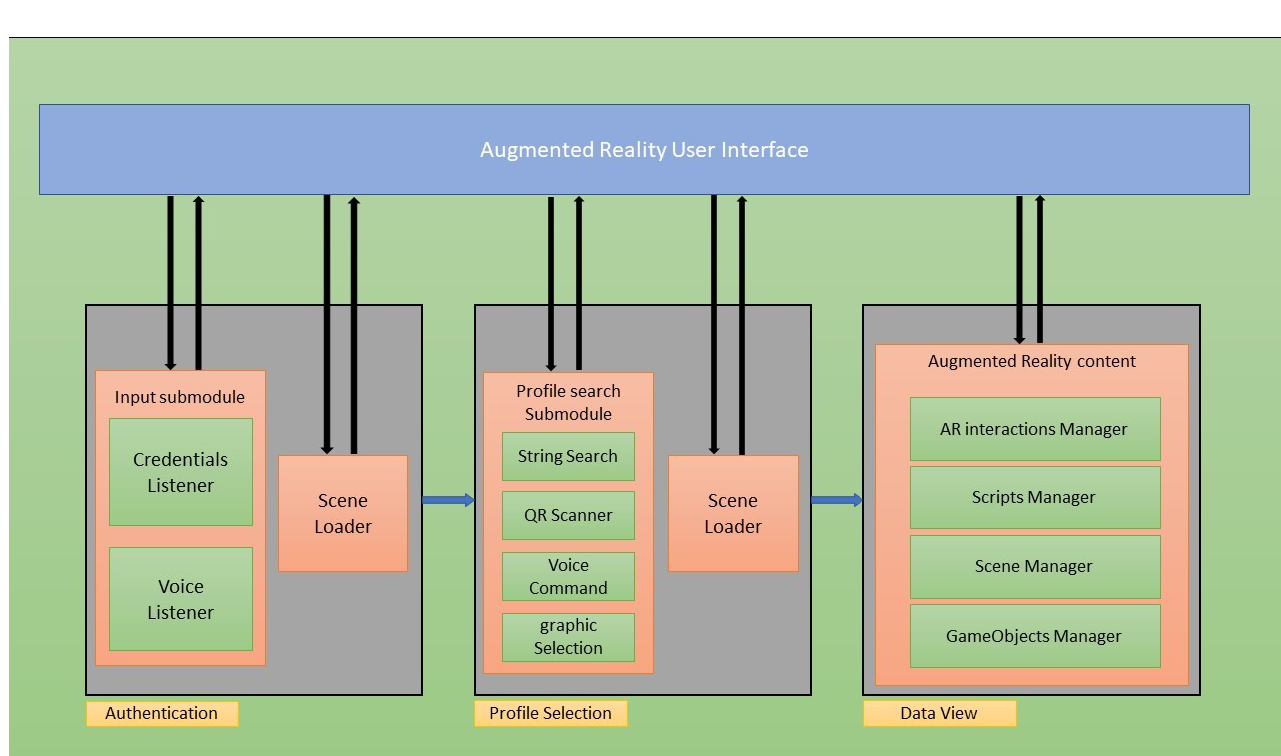
Figure 2. AR Component system in